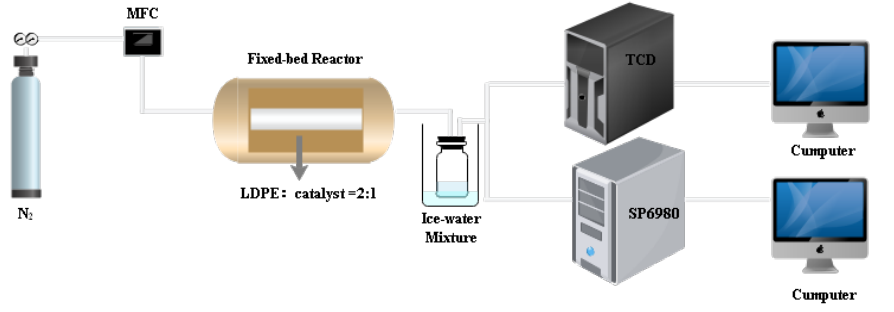
Figure 8. The pyrolysis experimental